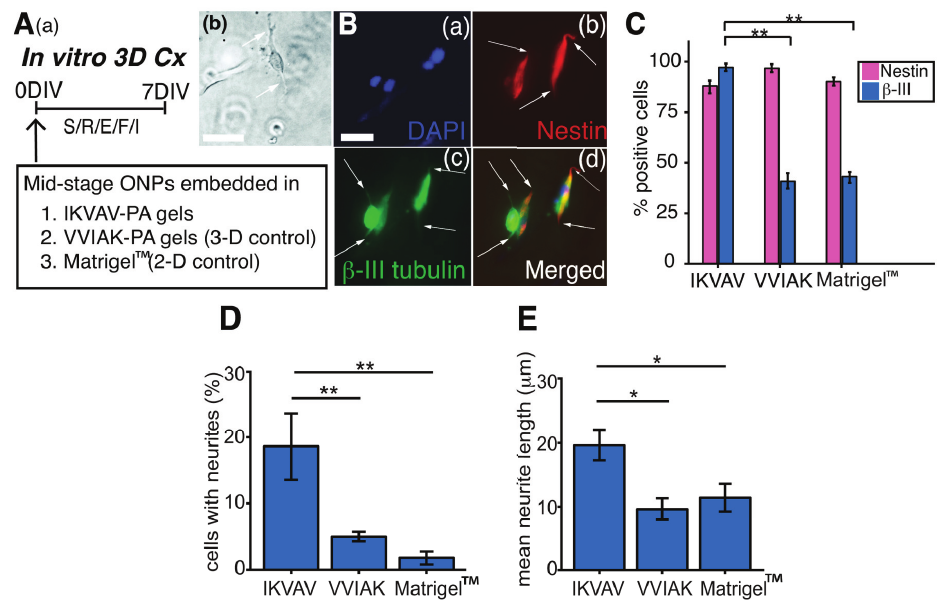
Fig 3. Neuronal differentiation of hESC-derived late-stage ONPs in IKVAV and VVIAK 3D matrices. (Aa) : An experimental paradigmon neuronaldifferentiationof hESC-derivedmid-stageONPs treated with S/ R/E/F/I in IKVAV & VVIAK PA gels (3-D) and Matrigel ™ (2-D) for seven days. DIV: days in vitro. (Ab) : A photomicrographof phase-contrasted image of a mid ONP treated with S/R/E/F/I in IKVAV-PA gels. A White arrow indicatesa neurite.Scale = 20 μ m. (B) : Immunocytochemistry of nestin and β -III tubulinfor hESC- derived mid-ONPs treated with S/R/E/F/I in IKVAV-PA gels. DAPI stain is shown in blue. A white arrow indicatesneurites. Scale bar: 20 μ m. (C) : Quantification of nestin and β -III tubulin-immunopositive cells on derived mid-stageONPs treated with S/R/E/F/I in IKVAV-PA gels, VVIAK-PA gels, and Matrigel ™ for 7 days. β -III: β -III tubulin. ( D ): Quantificationof neurite-bearingcells on derived mid-stageONPs treated with S/R/E/F/ I. in IKVAV-PA gels, VVIAK-PA gels, and Matrigel ™ .( E ): Quantificationof averageneurite length on S/R/E/F/ I-treated hESC-derived mid-stageONPs. ** p < 0.01, * p < 0.05 by one-wayANOVA with Tukey-Kramer’s post-hoc test. established 2-D culture system [8]. Fig 3A(b) shows a phase contrast photomicrograph of a hESC-derived mid-stage ONP treated with S/R/E/F/I for seven days in IKVAV-PA gels. The neurite-bearing cell displays the typical bipolar morphology of the otic neuronal lineage. Immunocytochemical characterization of late-stage ONPs embedded into IKVAV-PA gels is shown in Fig 3B; these bipolar cells also have extended neurites (white arrows in Fig 3B(b), 3B (c) and 3B(d)). Quantification of β -III tubulin expression and of neurite extension demon- strate the advantages of the IKVAV-PA matrix. With Matrigel™, only 42.4% ± 3.40 of these late-stage ONPs expressed the neuronal marker, β -III tubulin [54] (Fig 3C). Cells embedded in “scrambled” (VVIAK-PA) gels generated late-stage ONPs with strong nestin positivity (Fig 3C); however, only 39.6% ± 4.17 of cells expressed β -III tubulin (Fig 3C). In contrast, almost all cells in IKVAV-PA gels expressed strong positivity for both β -III tubulin (97.2% ± 1.83) (p < 0.01) and nestin (88.0% ± 3.74) (Fig 3C), suggesting that this matrix enhanced neuronal differentiation. The percentage of cells extending neurites (Fig 3D) was significantly higher in IKVAV-PA gels than in VVIAK-PA ( p < 0.01) or Matrigel™ ( p < 0.01) matrices (18.6% ± 5.05 for IKVAV-PA gels; 5.00% ± 0.71 for VVIAK-PA gels, and 1.80% ± 0.97 for Matrigel™). The average length of neurites (Fig 3E) was also about twice as long in IKVAV-PA gels than in the two controls (19.6 μm ± 2.36 for IKVAV-PA; 9.60 μm ± 1.72 for VVIAK-PA ( p < 0.05); and 11.4 μm ± 2.16 for Matrigel™ ( p < 0.05)). The combined enhancement in β -III tubulin